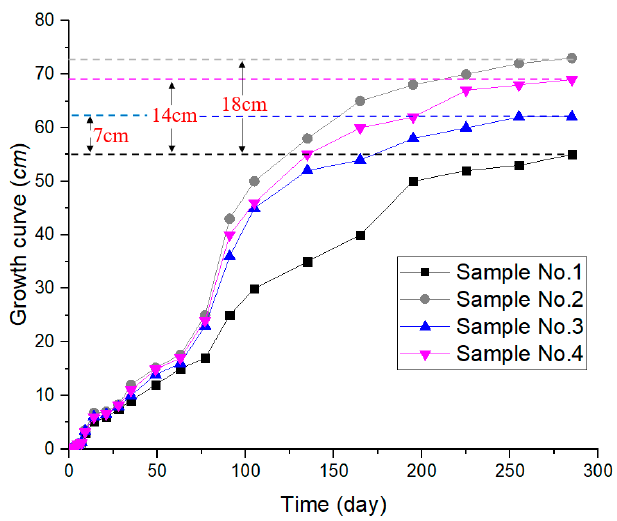
Figure 7. Plant growth